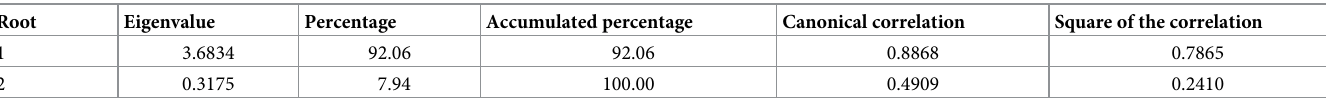
Each of the previous tests seeks to verify if the canonical correlations is equal to 0. As each p-value is below 0.05 there is an association between the two groups of variables. Table 6 contains the information of the eigenvalues and the canonical correlations. Each eigenvalue comes from the square of the canonical correlation between each of the variables. We observe that the first canonical correlation is 0.8868. The first canonical function is obtained in such a way that it reflects the greatest possible correlation between the two sets of variables. The first canonical function corresponds to the first eigenvalue, which explains 92.06% of the total of the correlation’s variability between the two groups of variables, while the second canonical function only explains 7.94%. Thus, the relation between both sets of Table 6. Eigenvalues and canonical